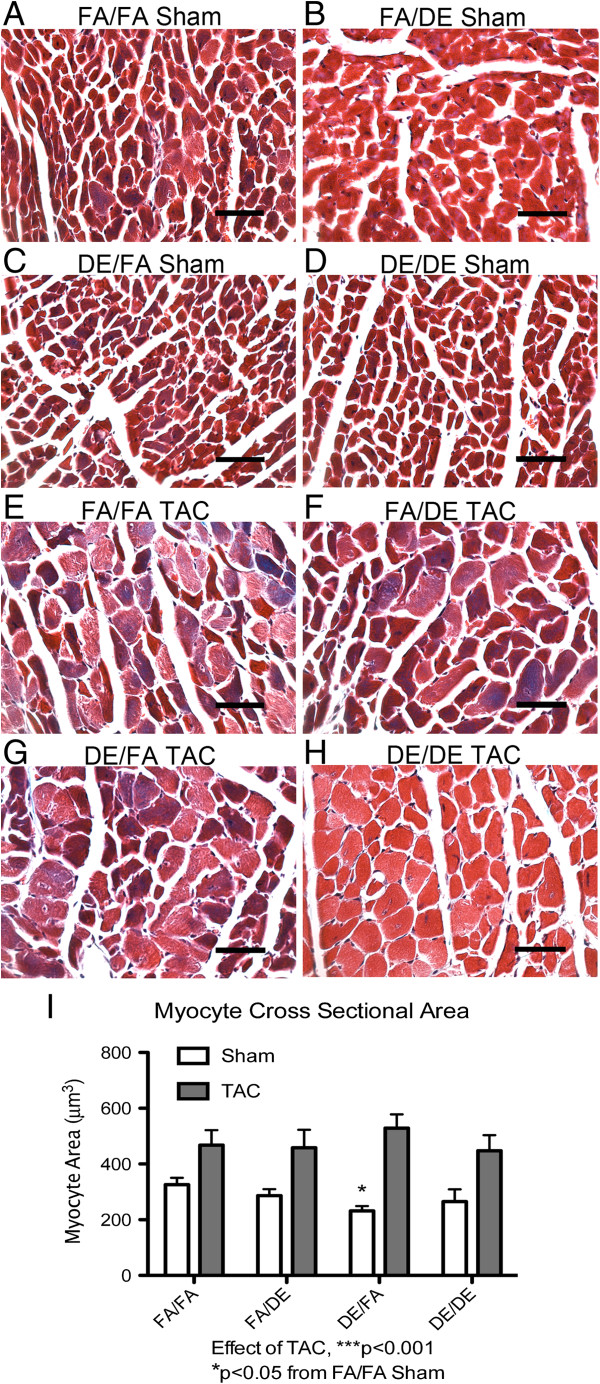
Measurement of individual cardiomyocyte hypertrophy. Representative images (40X objective) of sagittal sections of left ventricle free wall from mice three weeks post sham or transverse aortic constriction (TAC) surgeries (A-H), scale bar = 50 μm. Individual cardiomyocyte areas were traced, quantified, and analyzed in FA/FA (n = 5 sham, n = 5 TAC), FA/DE (n = 3 sham, n = 3 TAC), DE/FA (n = 5 sham, n = 5 TAC) and DE/DE (n = 5 sham, n = 4 TAC) groups (I).